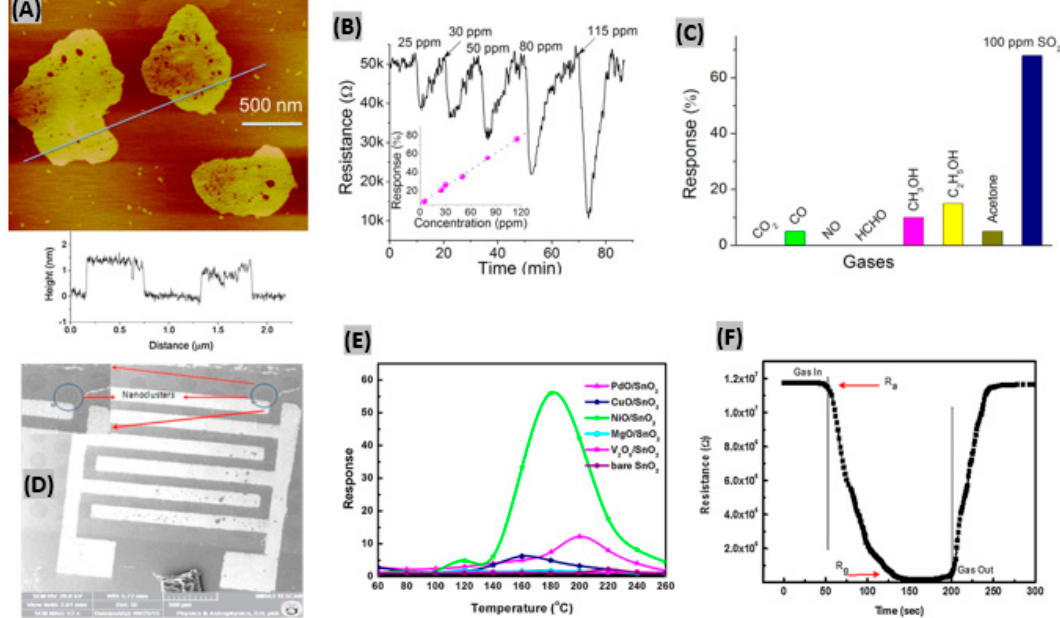
Figure 8. ( A ) Two-dimensional AFM image of ZnO nanosheets, height profile of two ZnO nanosheets as marked is shown below. ( B ) Resistance changes to SO 2 gas at different concentrations, inset shows plotting of sensing response vs. SO 2 concentration ( C ) Selectivity test of Ru/Al 2 O 3 /ZnO sensor to various gases under same concentration. Figures adapted with permission from [119], Copyright 2018 Elsevier. ( D ) SEM image of NiO/SnO 2 sensor structure, inset displays the presence of NiO